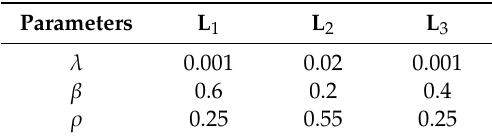
Table 8. Optimal parameter settings of each layer in the S-SAE for the Flevoland site.